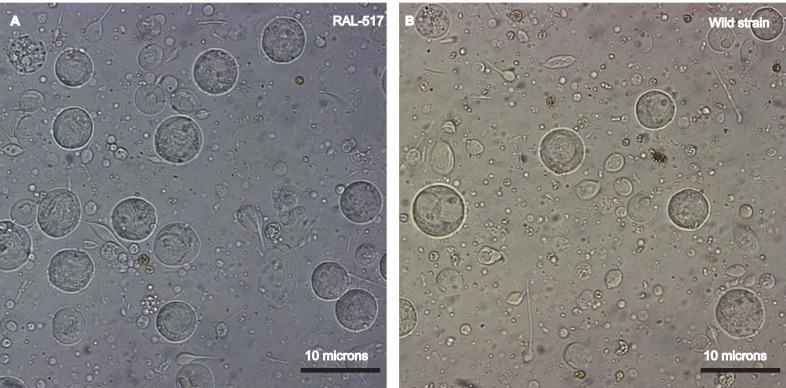
Establishing a single cell suspension from Drosophila testes.Representative images of single cell suspensions from two D. melanogaster strains, RAL 517 (A) and our lab’s wild strain (B). Dissected testes were treated with proteases followed by straining and washes (see Materials and methods). The images contain single cells of various developmental stages, some with tails of various lengths. Cells were imaged using a 40X magnification and scale bars represent 10 μm. Since cells are present in many focal planes, the size of some cells may not correspond to the scale bar shown.